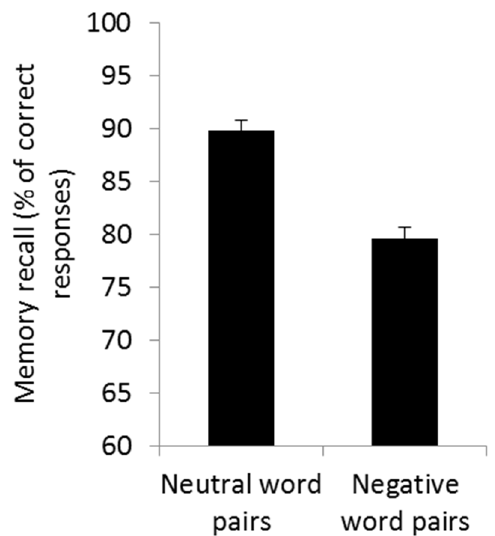
Figure 3. Memory performance for neutral and negative word pairs at the immediate recall task (IRT), expressed in percentage of correct responses. Error bars illustrate standard error.